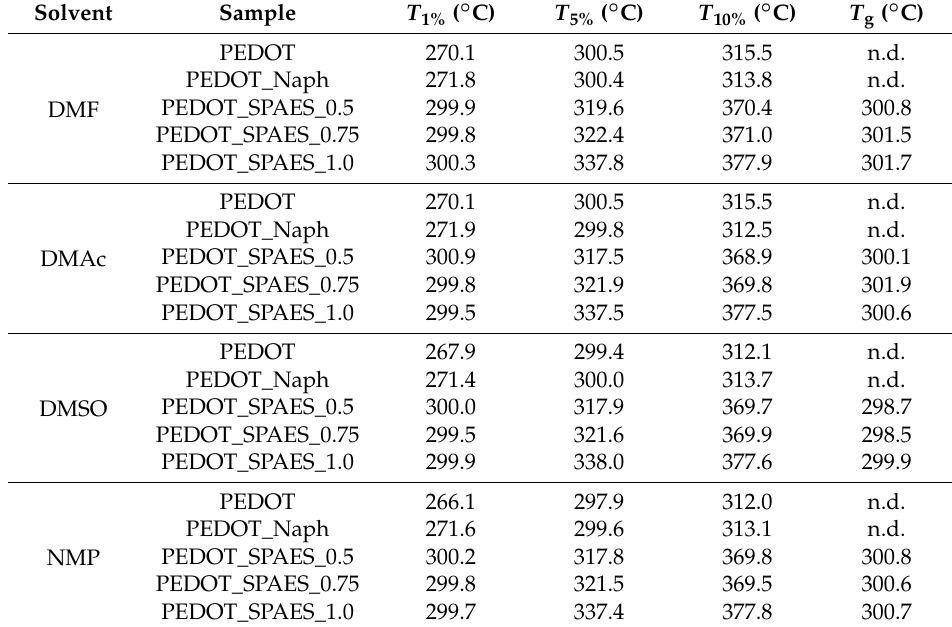
Table 3. Degradation and T g data of PEDOTs, PEDOT_Naphs, and PEDOT_SPAES